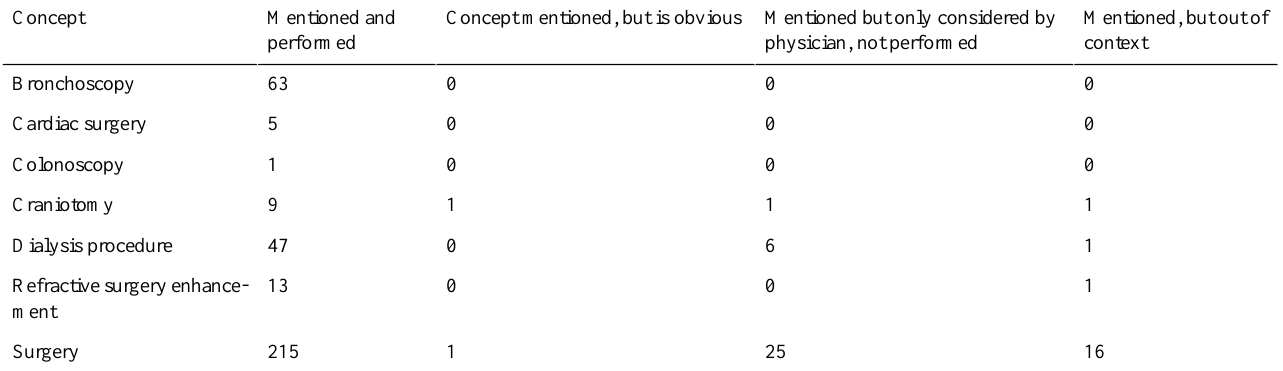
Table 5. Expert evaluation of true positive predictions using 4 fine-grained categories.